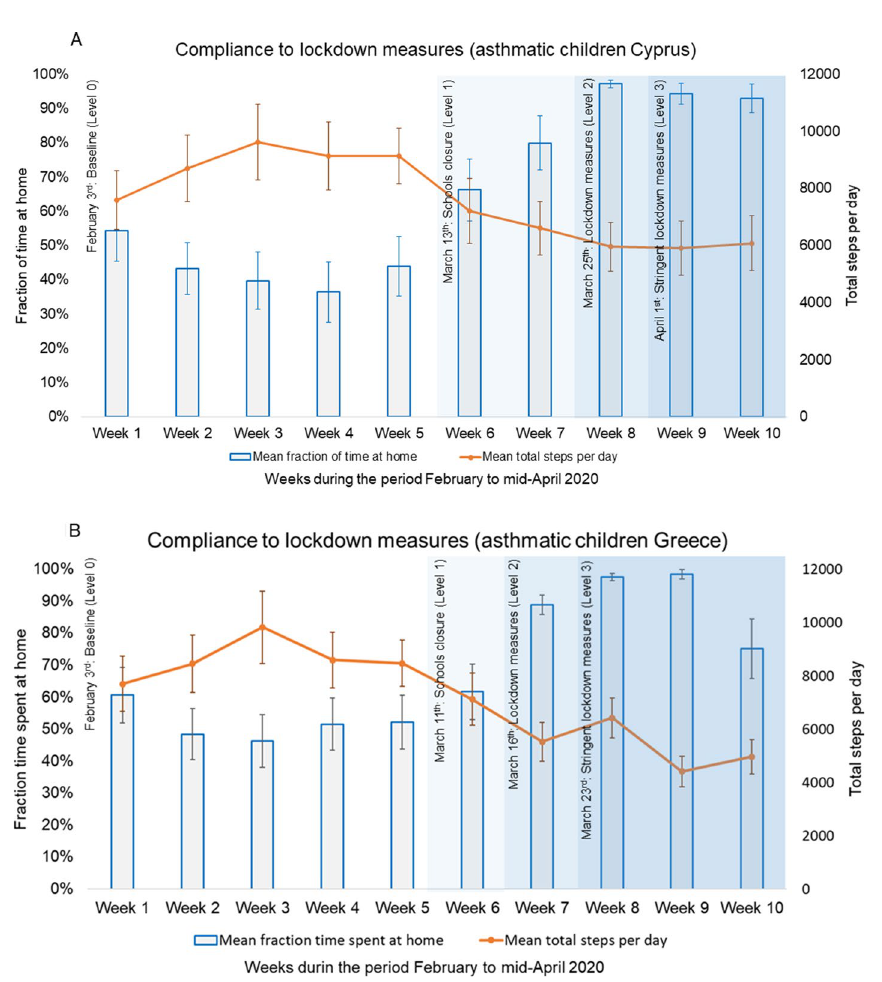
Figure 1. Changes in mobility in response to public health interventions among asthmatic children. Weekly averages of fraction time spent at home and steps/day, before and during three levels of public health interventions in asthmatic children in Cyprus ( A ) and Greece ( B